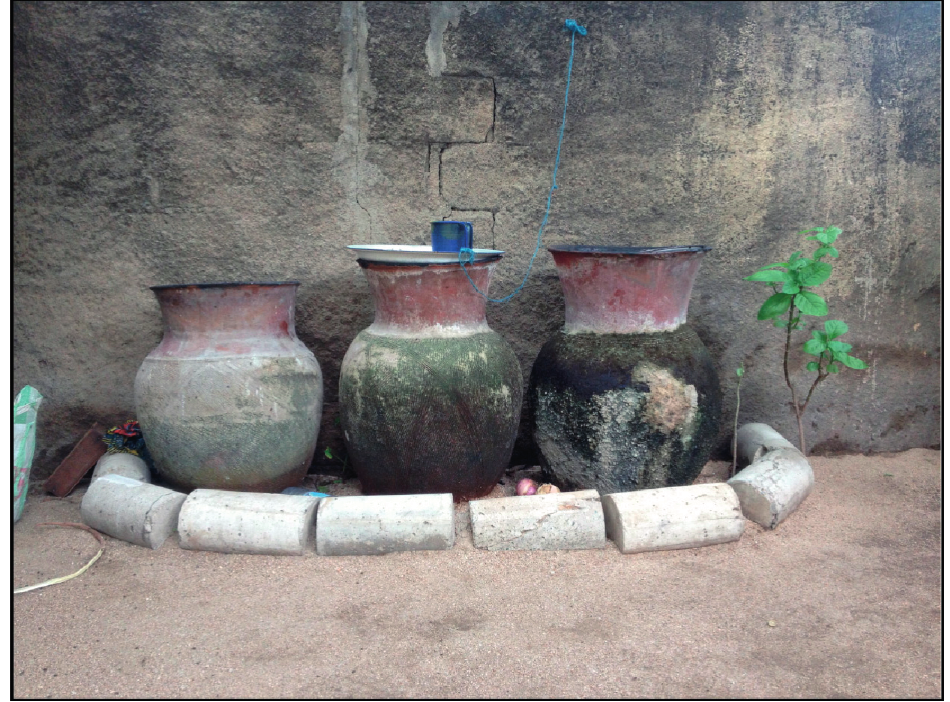
Figure 2. Canaries in a household’s compound being used for drinking water